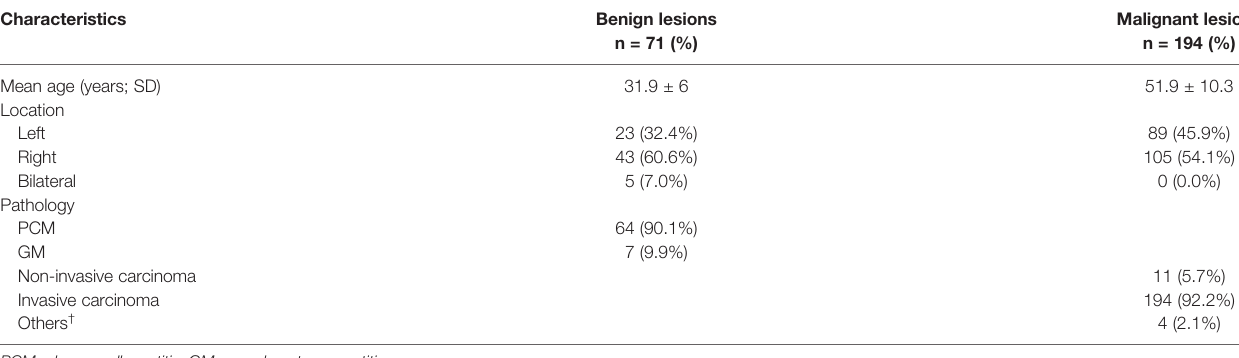
TABLE 1 | Baseline characteristics of the 93 patients included in the analysis. Characteristics